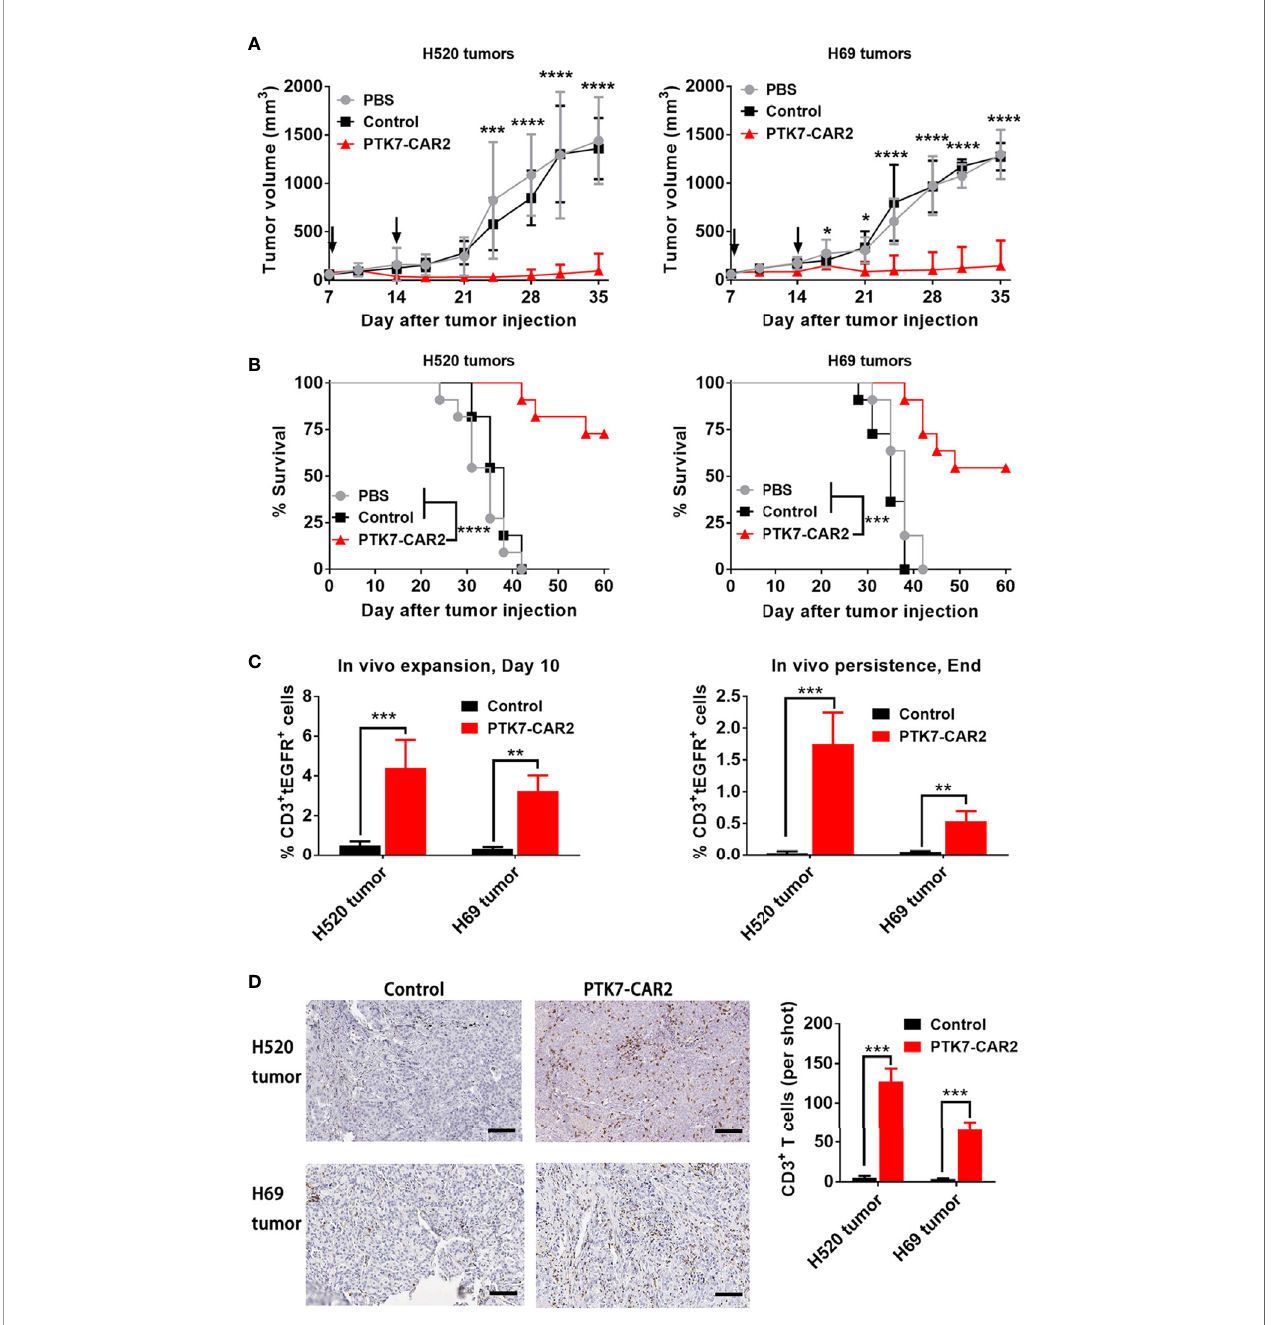
FIGURE 6 | Systemic treatment with PTK7-CAR2 T cells leads to tumor growth control and increased survival of mice in both human tumor xenograft models. (A) NSG mice were s.c. implanted with H520 or H69 tumor cells, after 7 days, received two intravenous infusion of control or PTK7-CAR2 T cells (5 × 10 6 cells in 100 µl PBS) week apart and tumor growth quanti fi ed by measuring tumor size. Data are shown as mean ± SEM (n = 5 mice per group). *P < 0.05, ***P < 0.001, and ****P < 0.0001, determined by repeated-measures two-way ANOVA with Tukey ’ s post hoc test. (B) Kaplan – Meier survival curves summarizing three independent experiments (n = 11 mice per group). ***P < 0.001, and ****P < 0.0001 determined by log-rank test. (C) Frequency of human CD3 + tEGFR + CAR T cells in the peripheral blood collected 10 days after T cell infusion or at the end of experiment. Data are shown as mean ± SEM (n = 4 mice per group). **P < 0.01 and ***P < 0.001, determined by repeated-measures two-way ANOVA with Tukey ’ s post hoc test. (D) Representative IHC images and quanti fi cation of T-cell in fi ltration in tumor tissues (n = 3) from treated mice harvested at the end of experiment. Scale bars, 100 µm. Data are shown as mean ± SEM (n = 3 mice per group). ***P < 0.001, determined by repeated-measures two-way ANOVA with Tukey ’ s post hoc